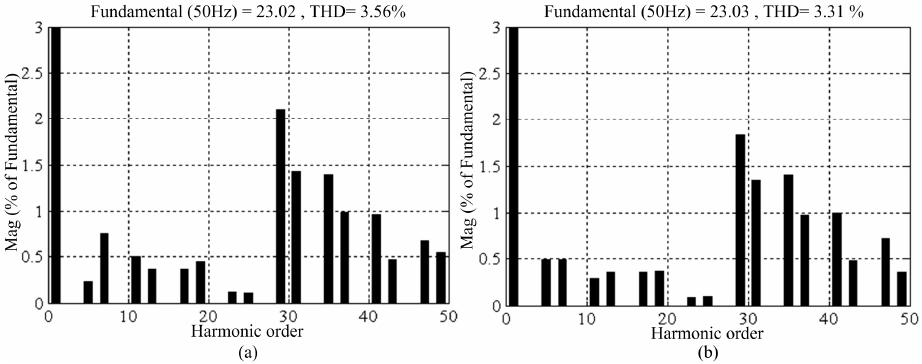
Figure 18. The FFT analysis of grid currents in steady-state condition. ( a ) PR control method; and ( b ) VPI control method.